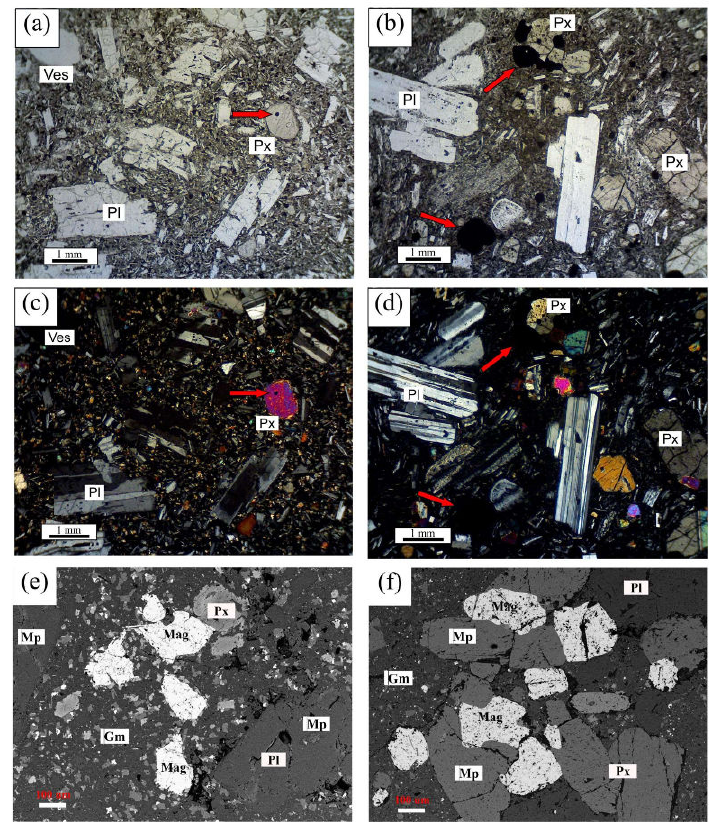
Figure 3. Thin sections show the opaque minerals (red arrow) and the differences of texture in parallel nicol mode of ( a ) IJ 3; ( b ) IJ 4 and cross nicol mode of ( c ) IJ 3; ( d ) IJ 4. BSE images of ( e ) IJ 3 and ( f ) IJ 4, show microphenocryst and groundmass microlite crystal population. Mineral abbreviations: Pl = plagioclase; Px = pyroxene, Ves = vesicular, Mag = titanomagnetite, Gm = groundmass microlite, Mp =